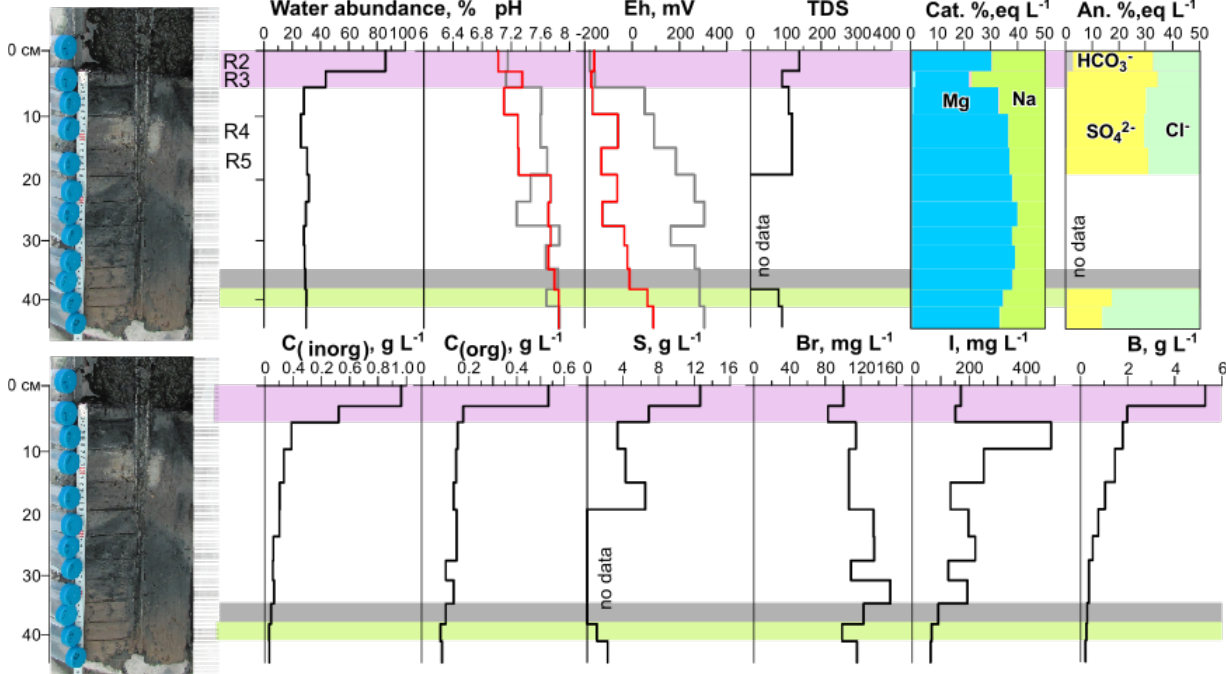
Figure 4. A change in water abundance, pH, Eh (red line: in suspension, gray: in a pore solution), salinity (total dissolved solids, g L − 1 ), distribution of main cations and anions in a solution along the column depth, levels of inorganic (C inorg ), organic carbon (C org ), S, Br, I, and B in the pore solution of the sediment from Lake Solenoe according to 2017 data. Layers 1 and 2 of the sediment are highlighted in pink, they feature high water abundance and considerable C org and C inorg contents in the solution. The border of Eh change from ( − ) to (+) is marked in gray. The layer in which the main anions change from Cl − –SO 42 − to Cl − –(SO 42 − ) is highlighted in green. The results of measuring Eh in the slurry (Eh 1 ) and in the squeezed-out pore solution The composition of surface solutions (water) from Lake Solenoe, the expeller extract from (Eh 2 ) in the upper two most water-rich layers were very close to each other and indicated the floating microbial community, and the pore solutions is presented in Supplementary Table